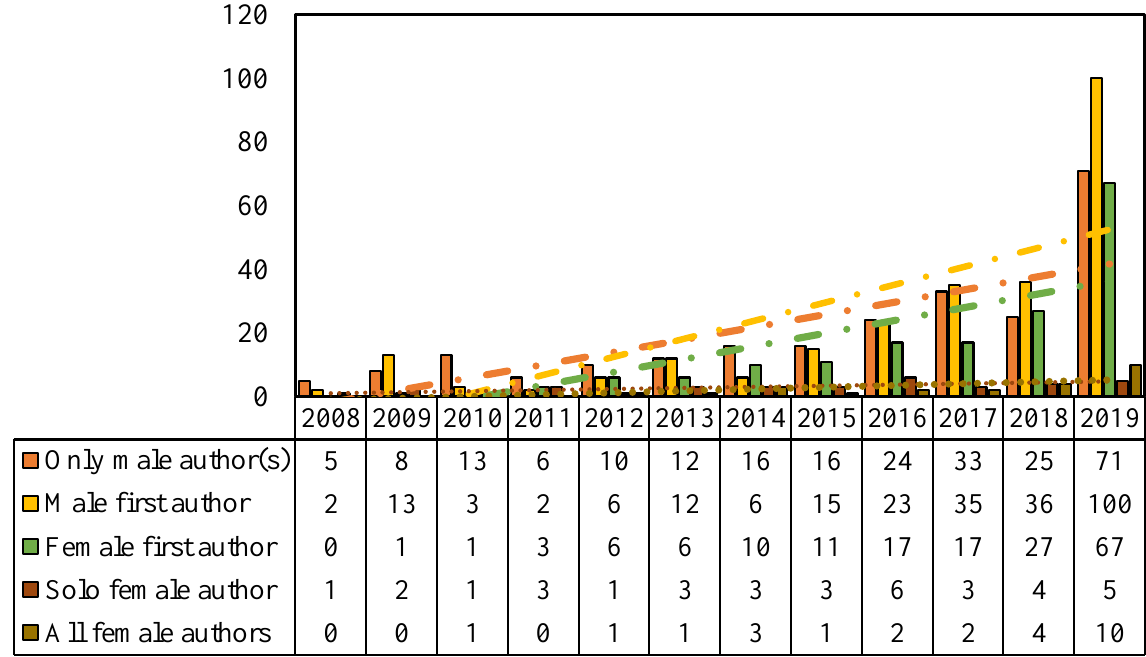
Figure 3. The annual Gold Access publications by the gender-based authorship structures.